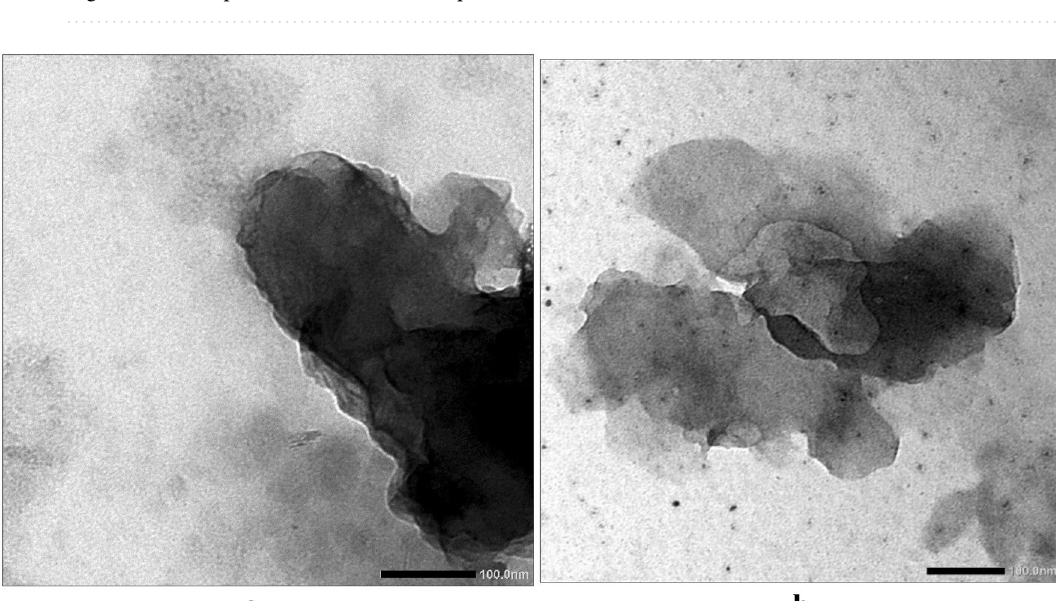
Figure 6. FTIR spectra of the SPS/GO composite.